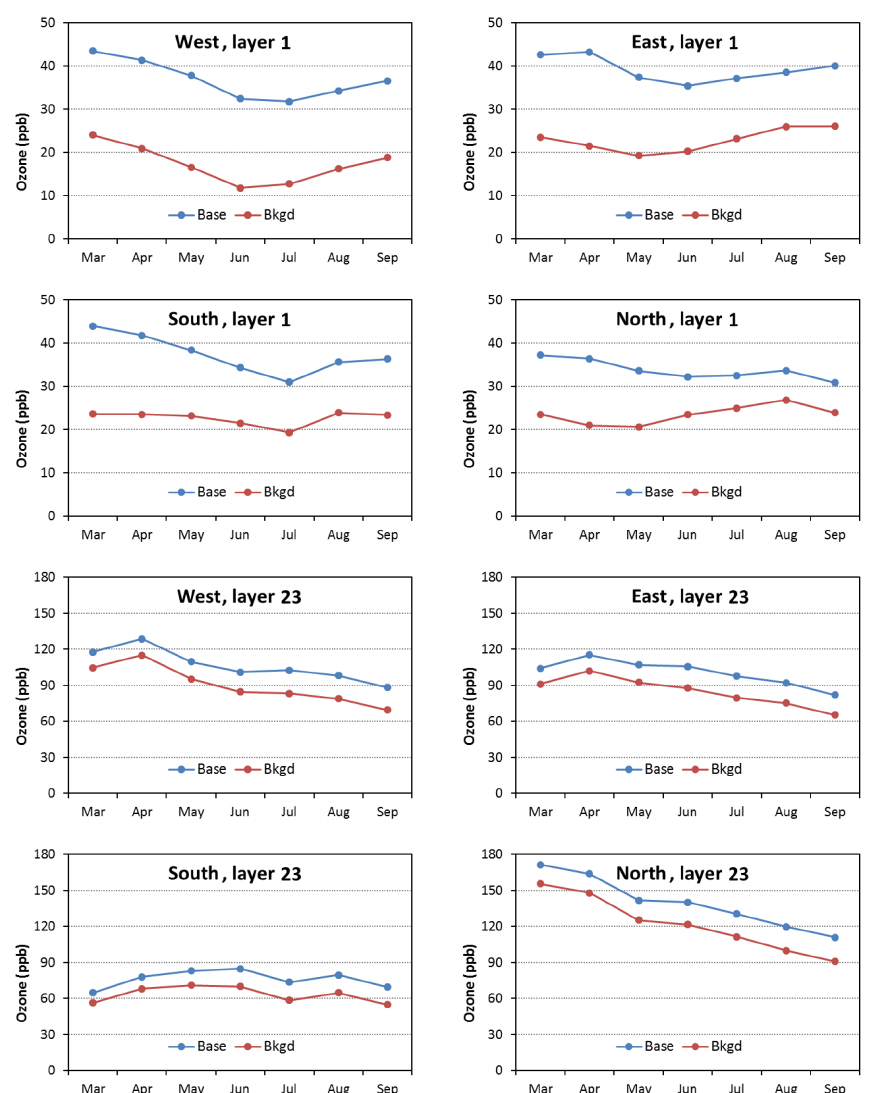
Figure 6. Monthly average lateral boundary O 3 concentrations for the CAMx surface layer and the 23rd layer, as provided by the GEOS- Chem